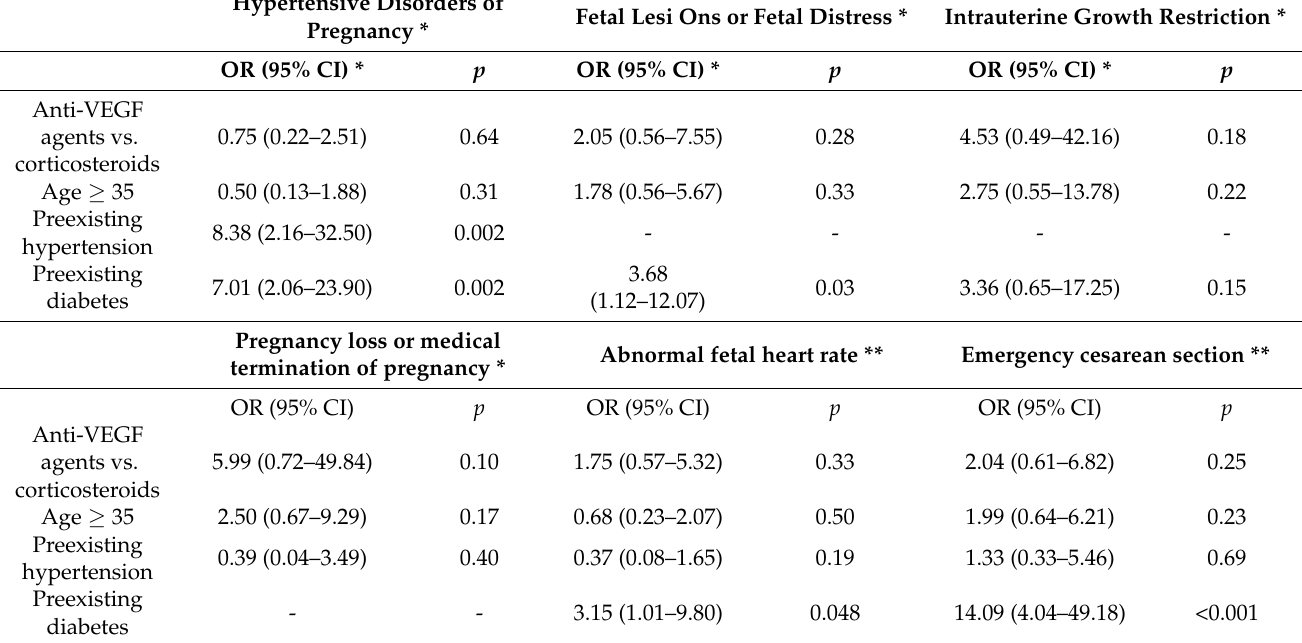
Table 6. Multivariable analysis of factors associated with obstetric and neonatal complications in women who had anti-VEGF IVTs only vs. women who had corticosteroid IVTs only during pregnancy or in the month preceding pregnancy, between 2013 and